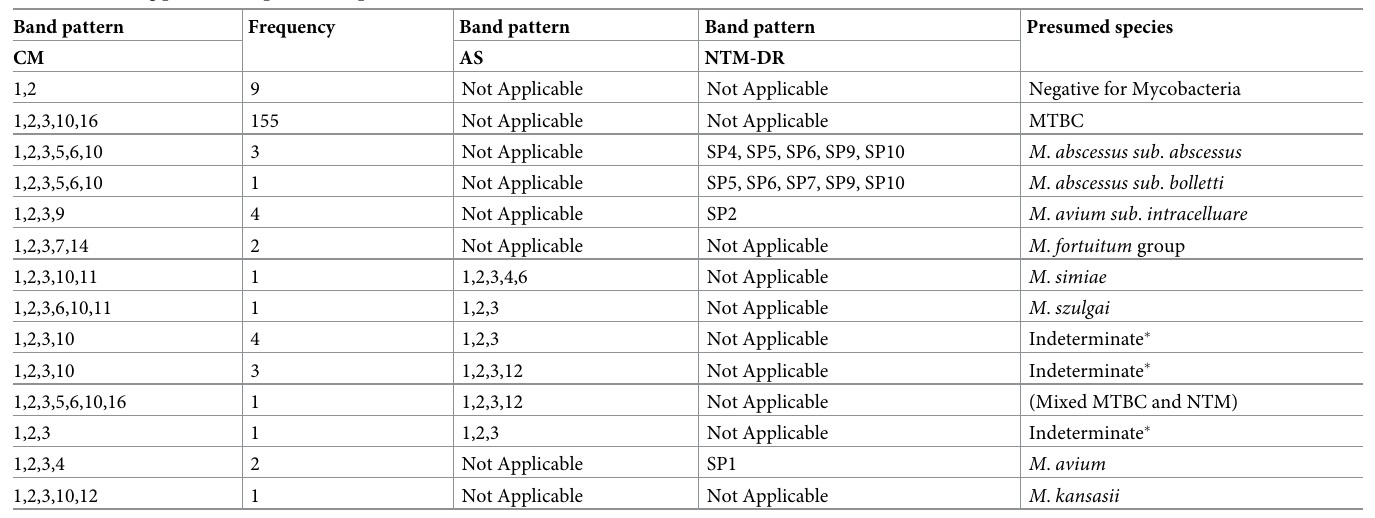
Table 1. Banding pattern and presumed